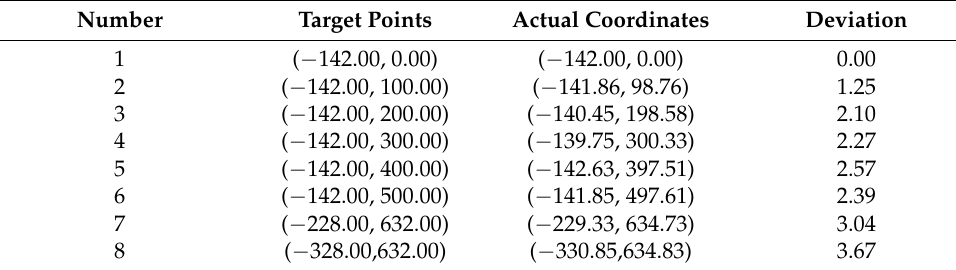
Table 4. “Improved L”path cruise test data Unit: